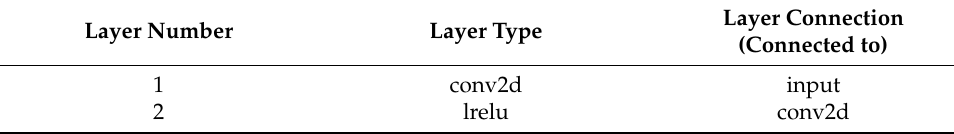
Total number of trainable parameters: 1,947,137. Table 7. Description of a convolution block of the discriminator network.